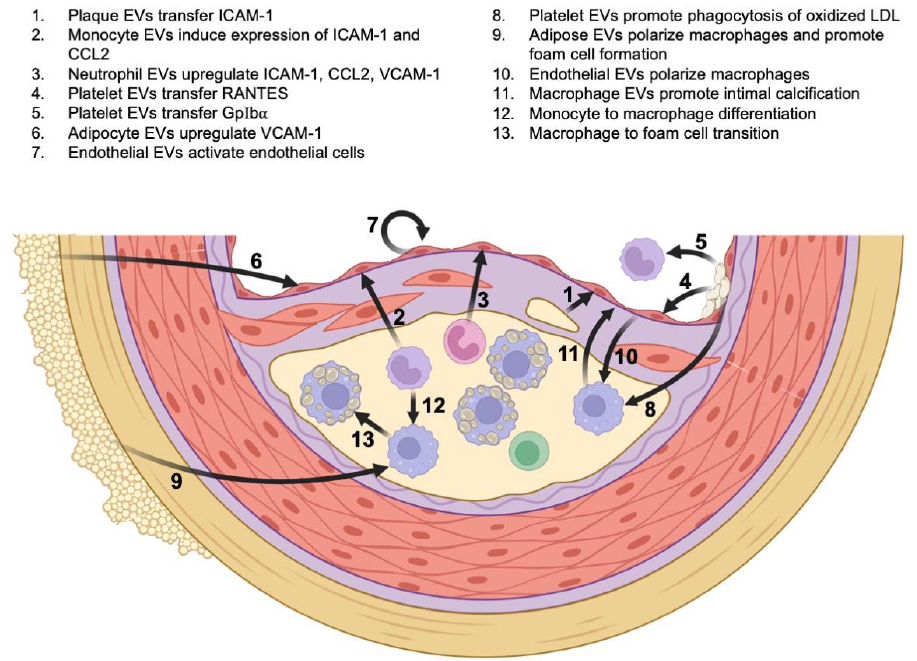
Figure 2. The role of EVs and inflammation in atherosclerosis. Mechanistic links between EVs, inflammatory mediators, and atherosclerotic plaque progression.